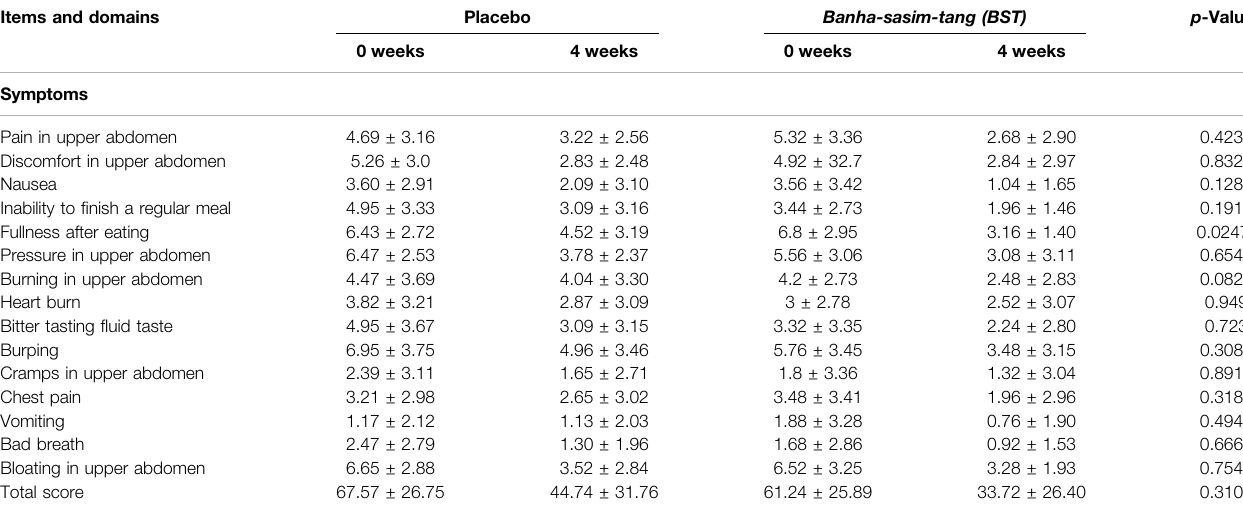
TABLE 2 | Symptom scores using Nepean Dyspepsia Index (NDI). Items and domains